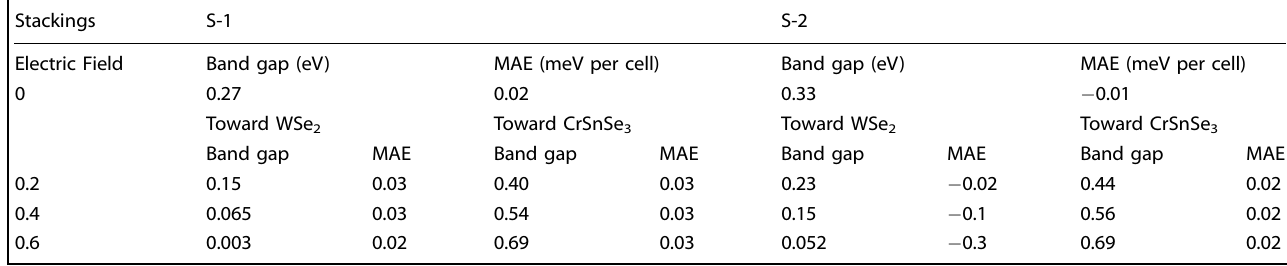
Table 1. Electric fi eld dependent band gap (in eV) and magnetocrystalline anisotropy energy (MAE) (in meV per cell). Stackings S-1 S-2 Electric Field